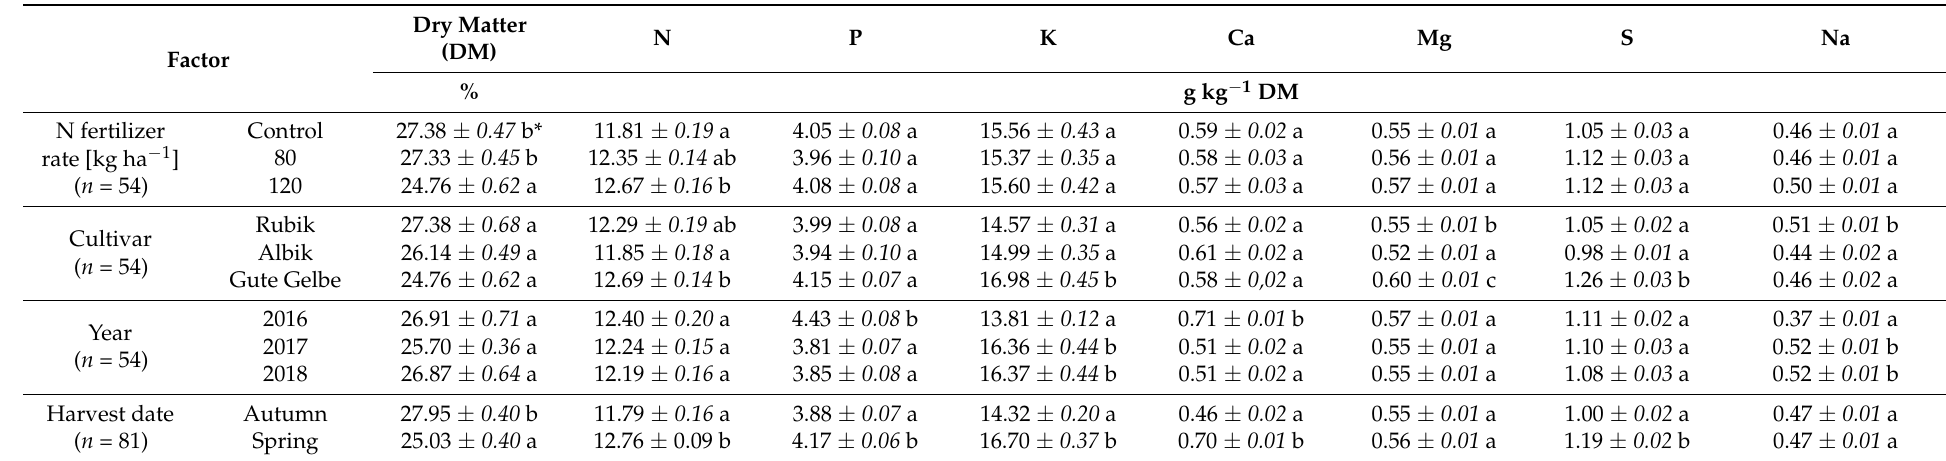
Table 5. Dry matter weight and macronutrients and Na concentration in Jerusalem artichoke tubers (average ± SE